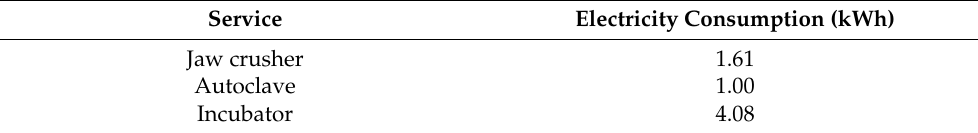
Table 4. Energy consumption data of services.